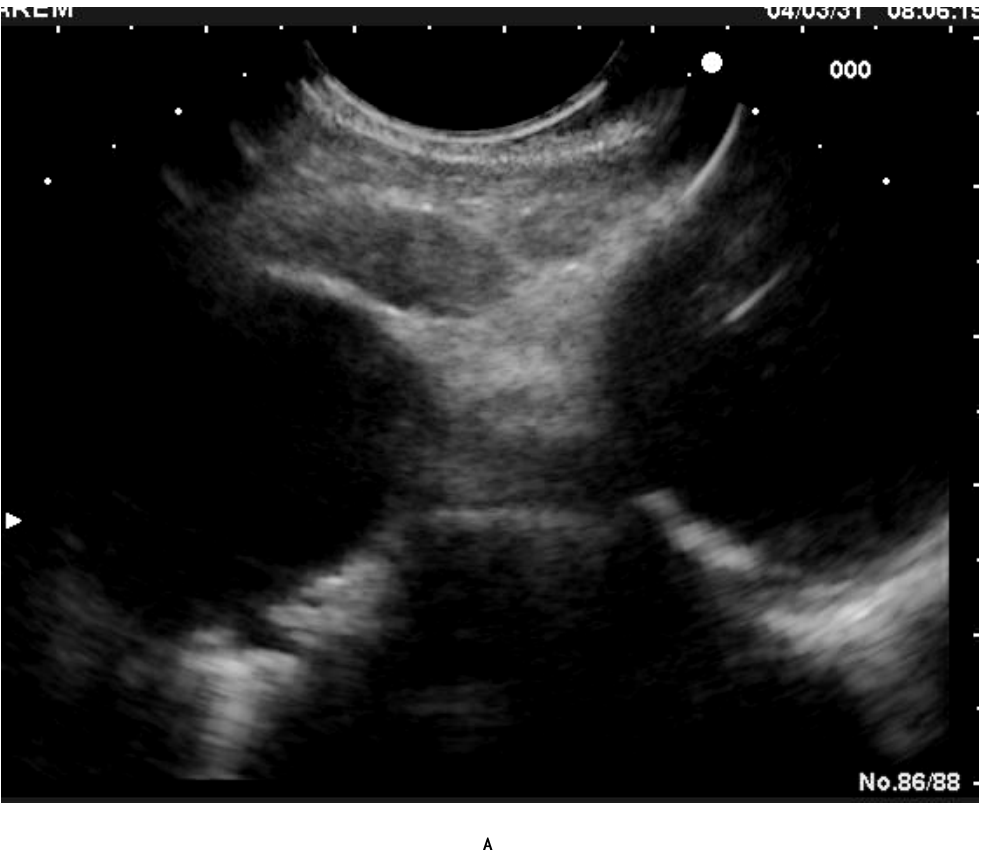
A FIGURE 17. (A) Mediastinal LN; (B) elastography: inflammatory LN: Score